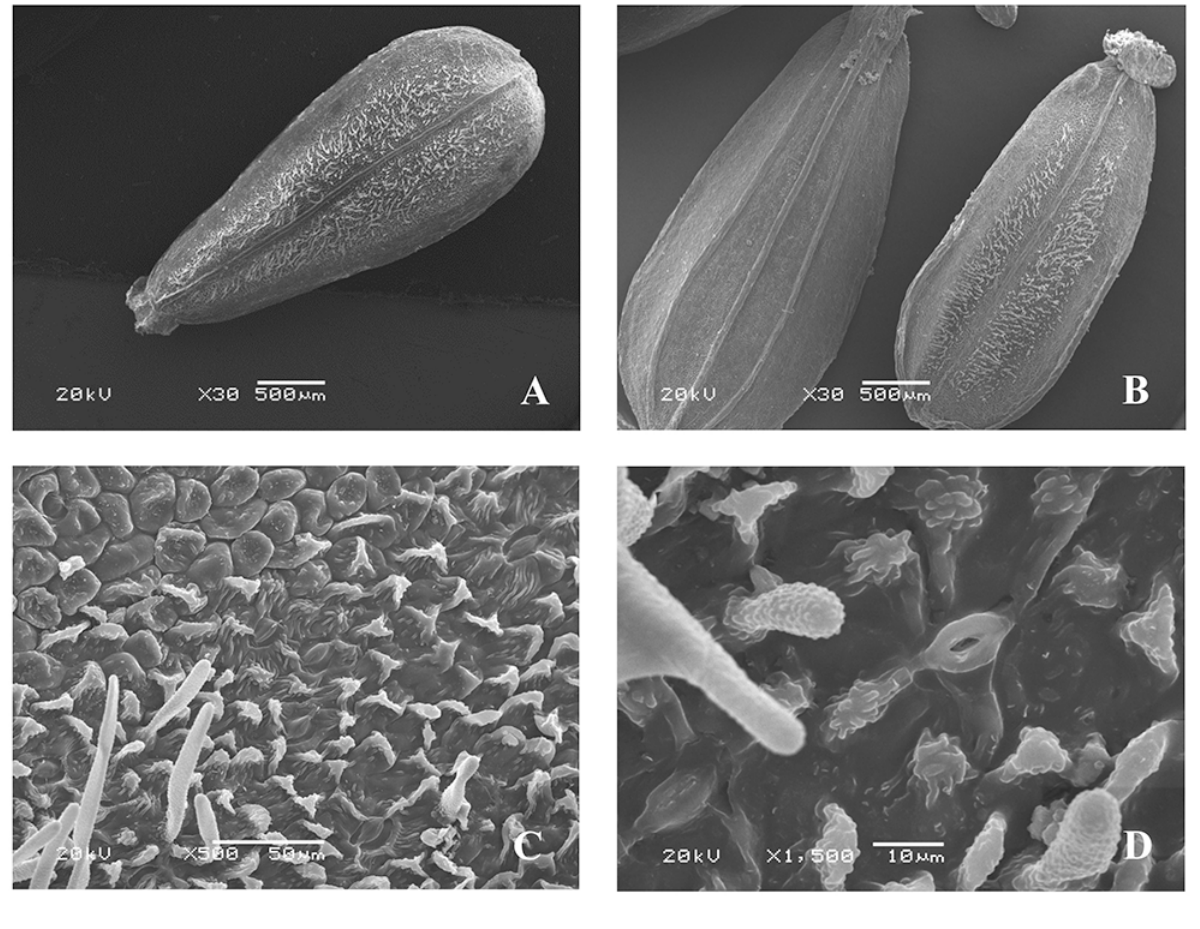
Figure 7 Fruits of V. grossheimii Worosch. (SEM): General view, adaxial side ( A ); general view, abaxial side ( B ); fragment of the fruit surface ( C ); stomium ( D